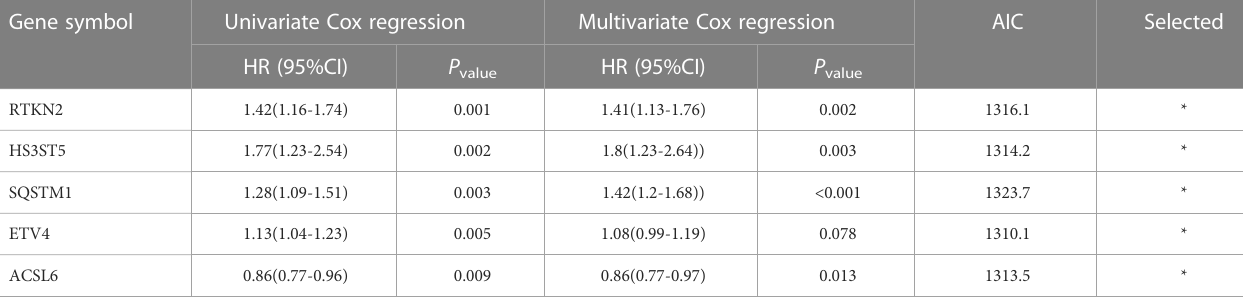
TABLE 1 Univariate and multivariate Cox regression in TCGA-LIHC patients. Gene symbol